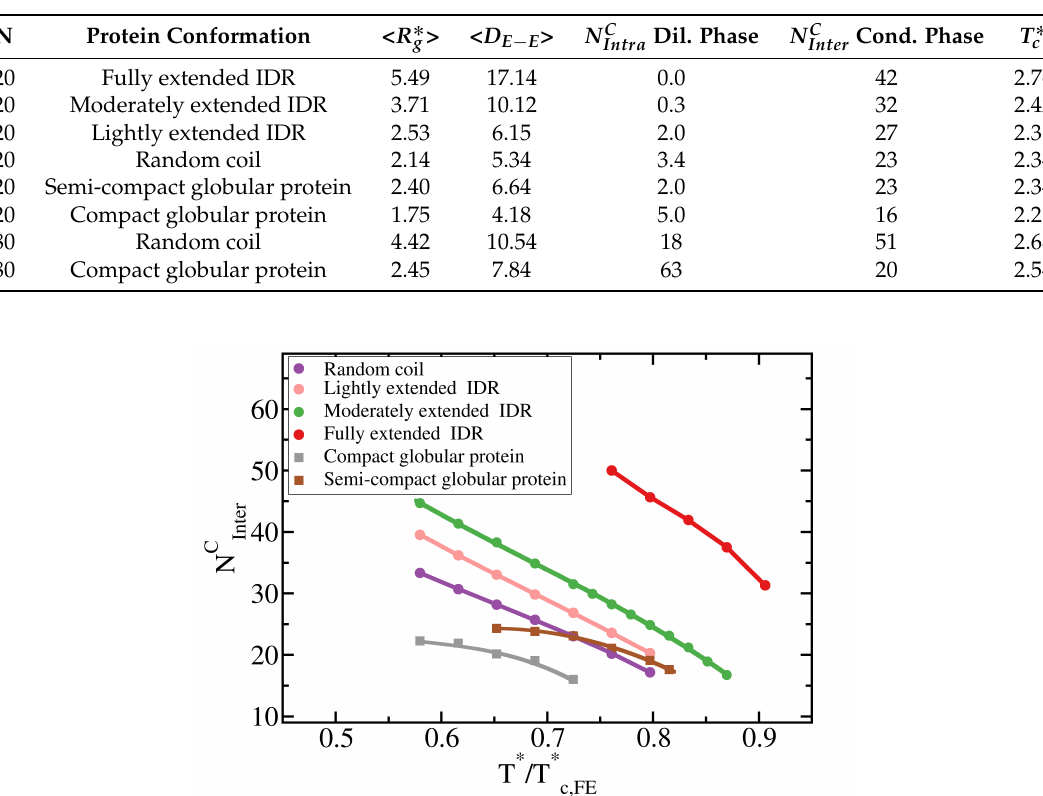
) in the diluted phase; number of inter-molecular contacts Intra ) and critical temperature ( T ˚ c ) of the different studied Inter and N C for the 20-bead (80-bead) Intra Inter ( T ˚ “ 0.9 T ˚ ) and to the density of the c , FE c , RC = 2.76 and T ˚ = 2.68. Please note that the c , FE c , RC